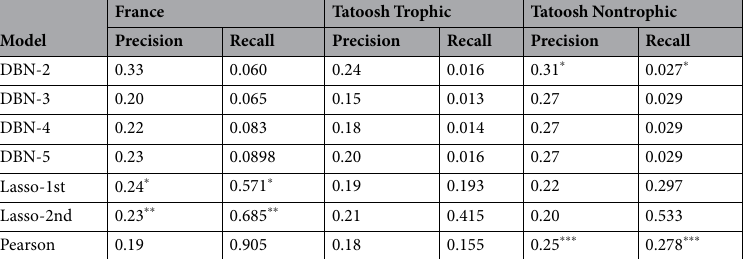
Table 1. Precision and recall of model networks compared to empirical network structures for the French stream trophic network, Tatoosh trophic network, and Tatoosh nontrophic network. Precision and recall values are given with significance based on a permutation test ( < 0.05: * , < 0.01: ** , < 0.001: *** ), with p -values corrected across all models and networks for an overall false discovery rate of α = . 0 05